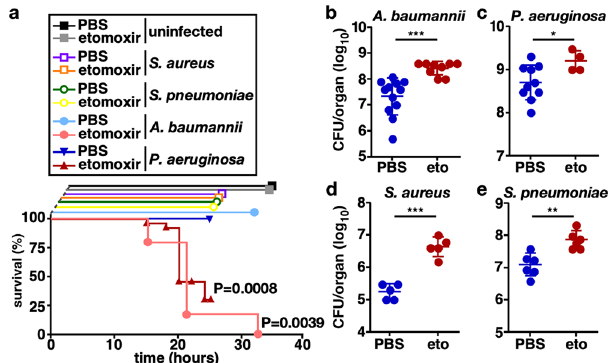
Fig. 2 Pharmacologic Cpt1a inhibition enhances pneumonia disease severity in mice. a Mice were treated with the Cpt1a inhibitor, etomoxir, or PBS carrier and challenged intranasally with the bacterial lung pathogens A. baumannii , P. aeruginosa, S. aureus, or S. pneumoniae or mock-infected with intranasal instillation of PBS and survival was monitored over time. Survival of etomoxir-treated and control animals was assessed using a Kaplan – Meier analysis and the P values determined by a log-rank test for A. baumannii and P. aeruginosa- infected mice are depicted. Mice were challenged intranasally with A. baumannii at a reduced inoculum, P. aeruginosa , S. aureus , or S. pneumoniae and bacteria were enumerated from the lungs at 12 h ( b ) or 24 h ( c – e ). Circles represent data from individual animals, the horizontal line represents the mean, and error bars depict the standard deviation. c In all, 9 of 13 animals in the etomoxir group were censored due to mortality compared with 0 of 10 in the PBS group. Means were compared using a Welch ’ s t test. CFU/organ,